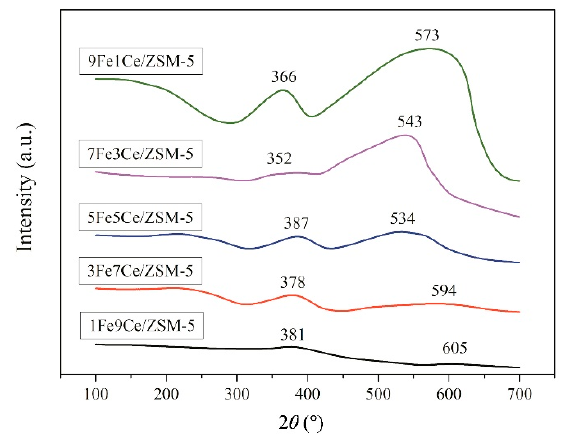
Figure 4. H 2 -TPR profiles of x Fe y Ce/ZSM-5.